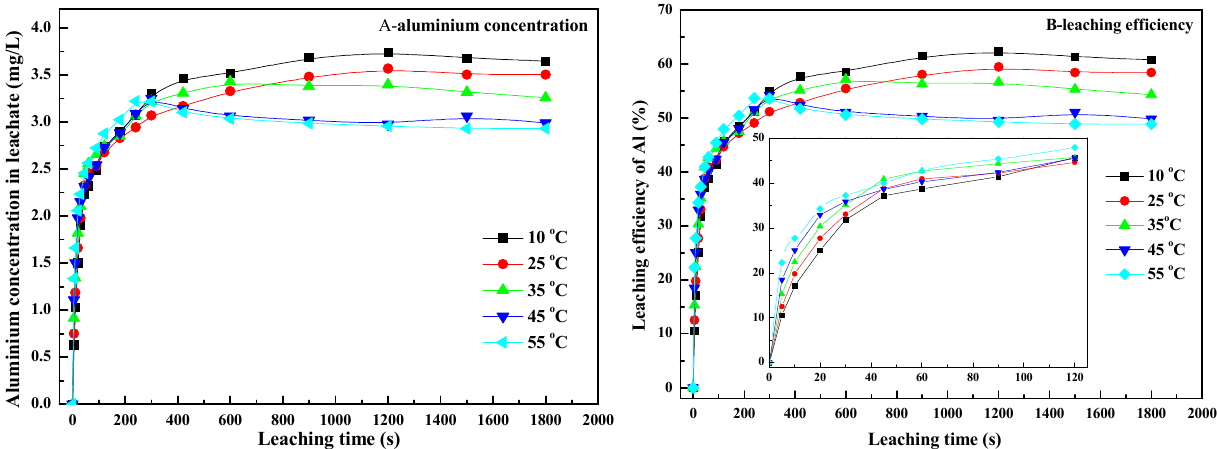
Figure 8. Effect of temperature on the leaching of aluminum (C 0 = 0.20 mol/L, stirring speeds 400 r/min).